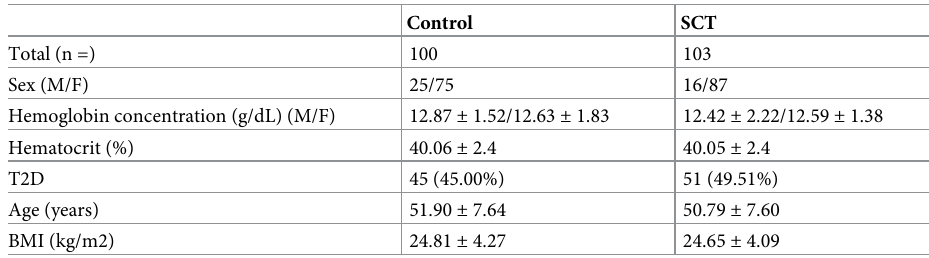
Table 1. Participant